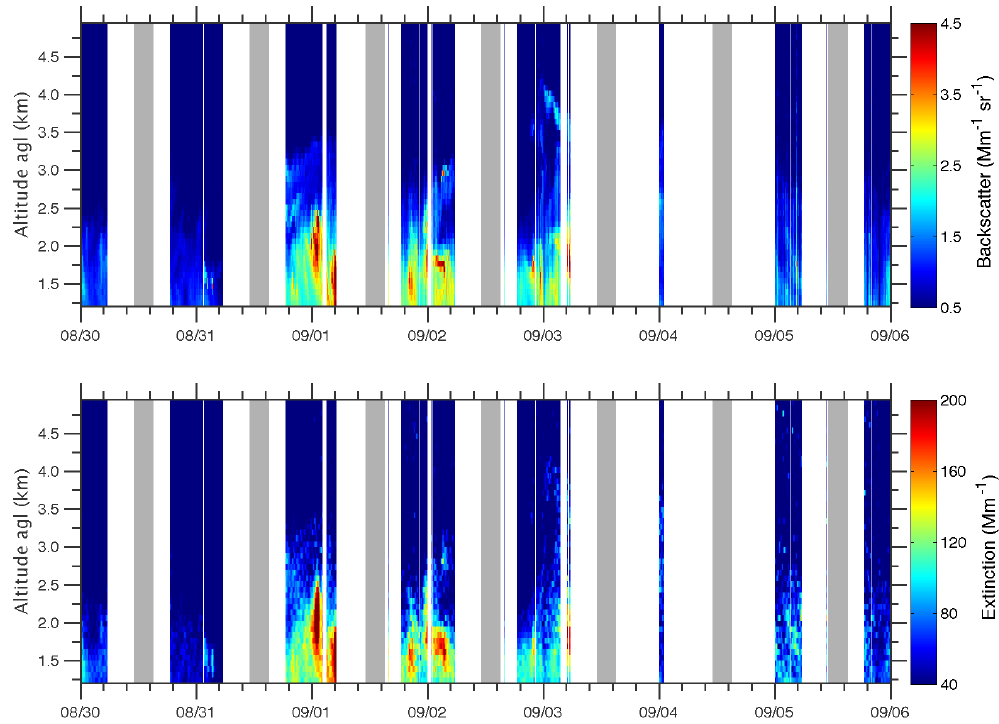
Figure 11. Aerosol backscatter (top, Mm − 1 sr − 1 ) and extinction (bottom, Mm − 1 ) obtained from a Raman inversion are shown above 1km from 30 August to 6 September 2011. Gray and white regions correspond to local solar noon and clouds, respectively.